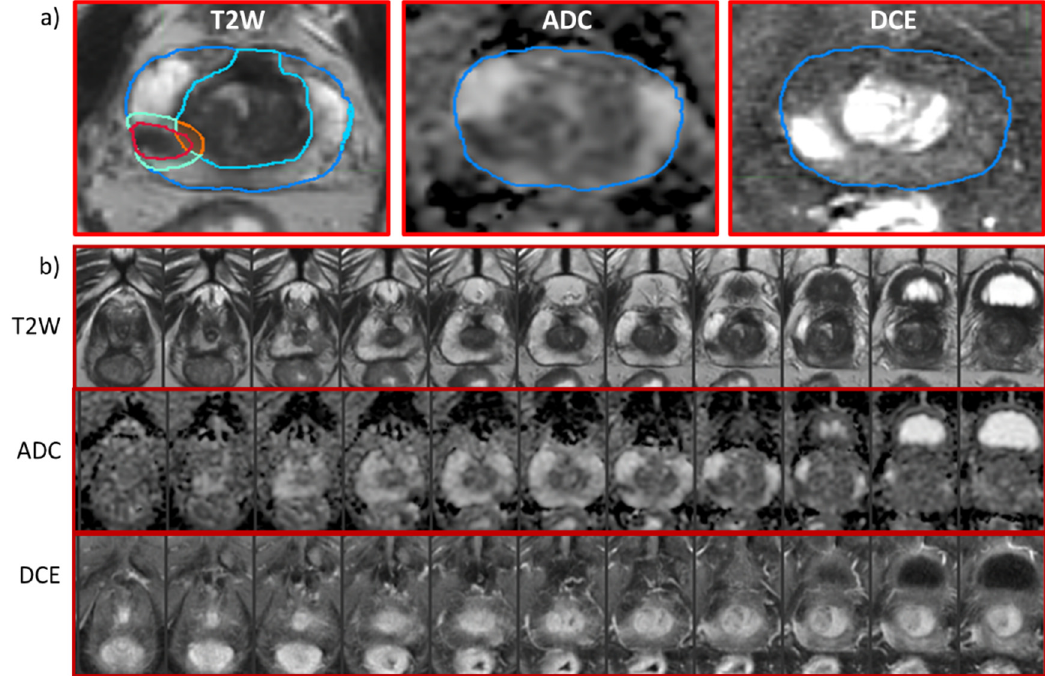
Figure 3. MpMRI sequences and segmented ROIs for analysis. ( a ) Representative axial slices from mpMRI of a patient at a baseline: T2-weighted, ADC, and early enhancing DCE-MRI series. The contours in the T2-weighted image are of the prostate (blue) and PZ (cyan). Gross Tumor Volume (GTV) is outlined in red; peri-tumoral GTV is represented by turquoise within the peripheral zone (PT-PZ) and orange contour within transitional zone (PT-TZ). ( b ) Axial slices through the entire prostate from apex to base on T2-weighted, ADC and early enhancing DCE-MRI series. The eight slice (from left to right) corresponds to the image in panel a).